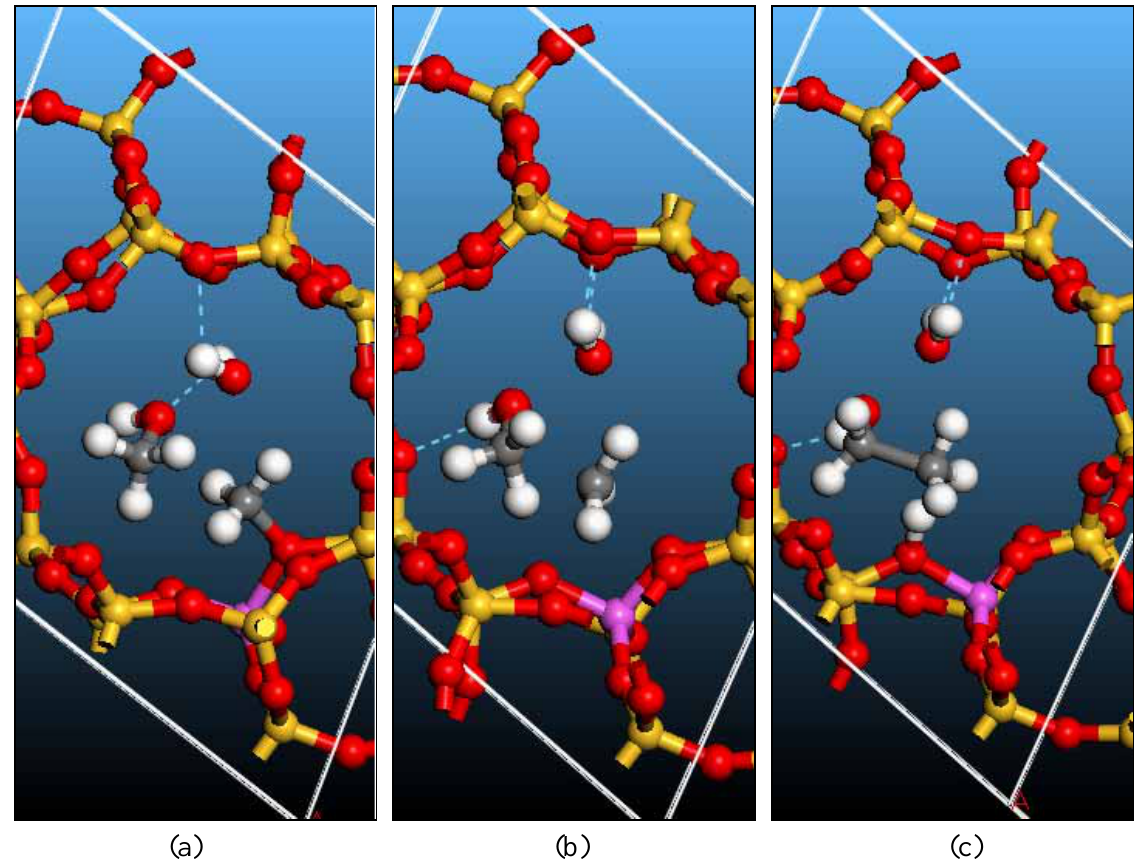
2 type reaction involving the N